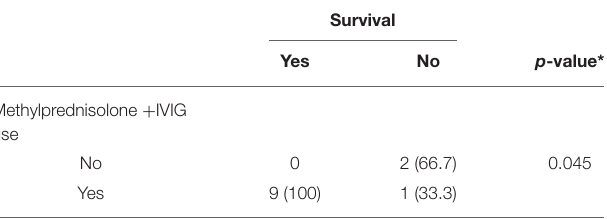
TABLE 6 | The Bivariate association between IVIG and IV methylprednisolone use with the survival: ( n =